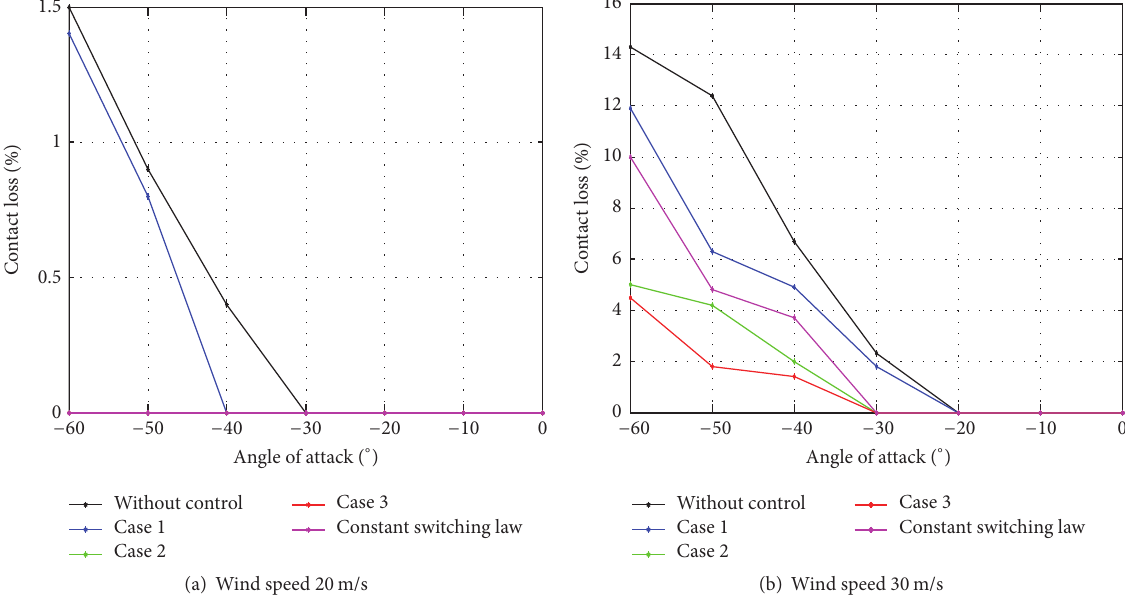
Figure 17: Results of percentage of contact loss with different wind speeds and angles of